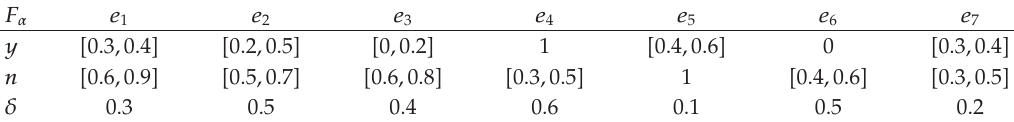
Table 5: GIVFSS for the sick